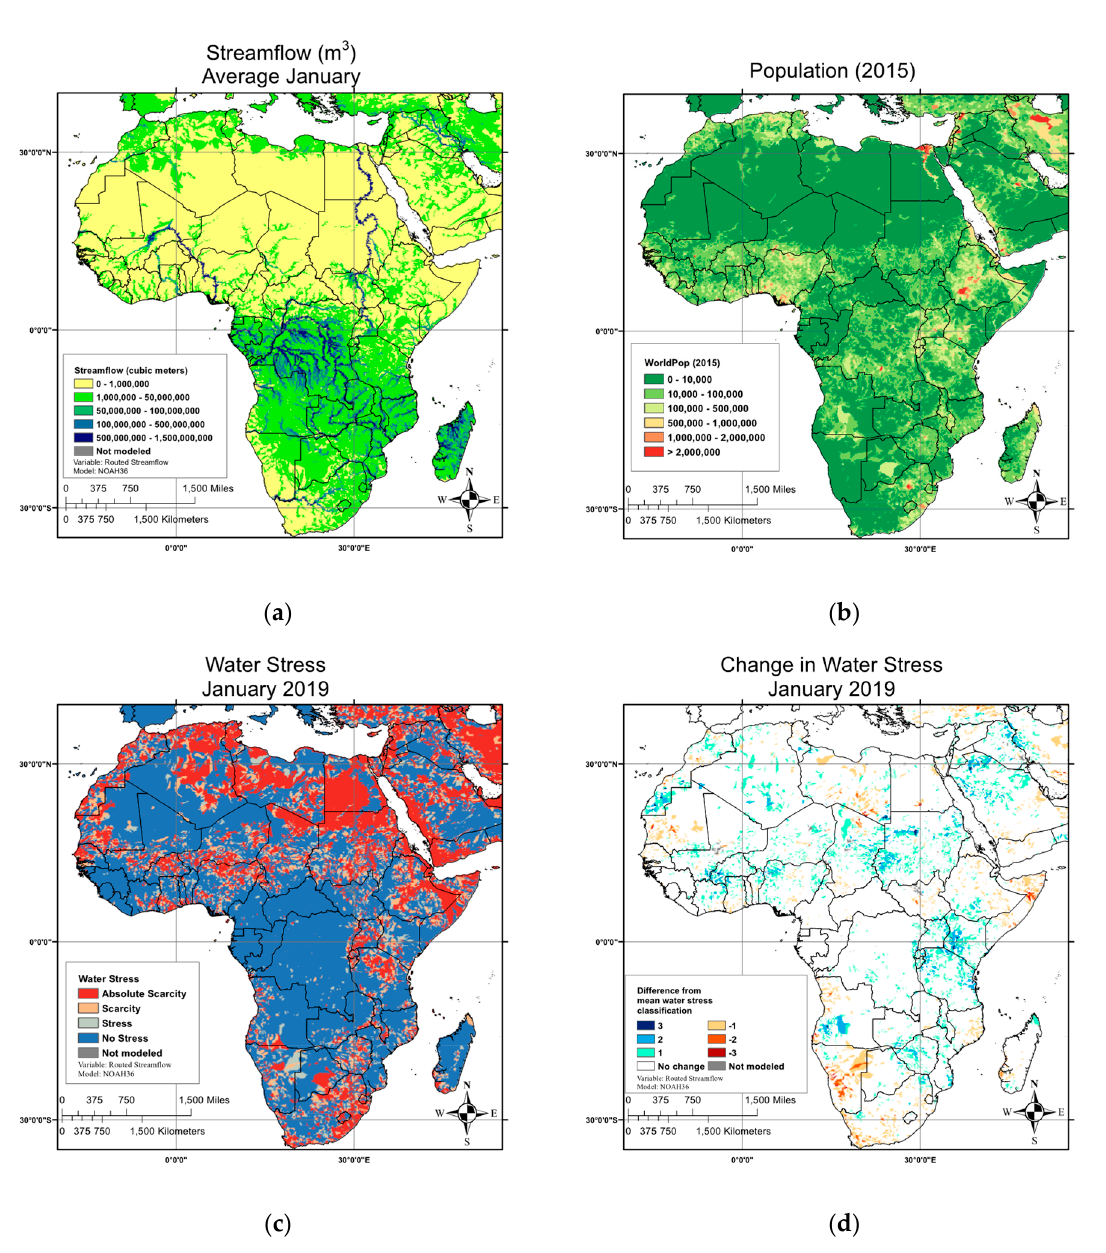
Figure 2. The components of the Africa water scarcity monitoring scheme using average January streamflow as an example: ( a ) Streamflow for January plus 11 previous months, averaged over Pfafstetter 6 basin units; ( b ) WorldPop 2015 population density averaged over Pfafstetter 6 basin units; ( c ) example map of the Falkenmark Index categories in January 2019; ( d ) Example map showing January 2019 departures from average January conditions, highlighting acute events.